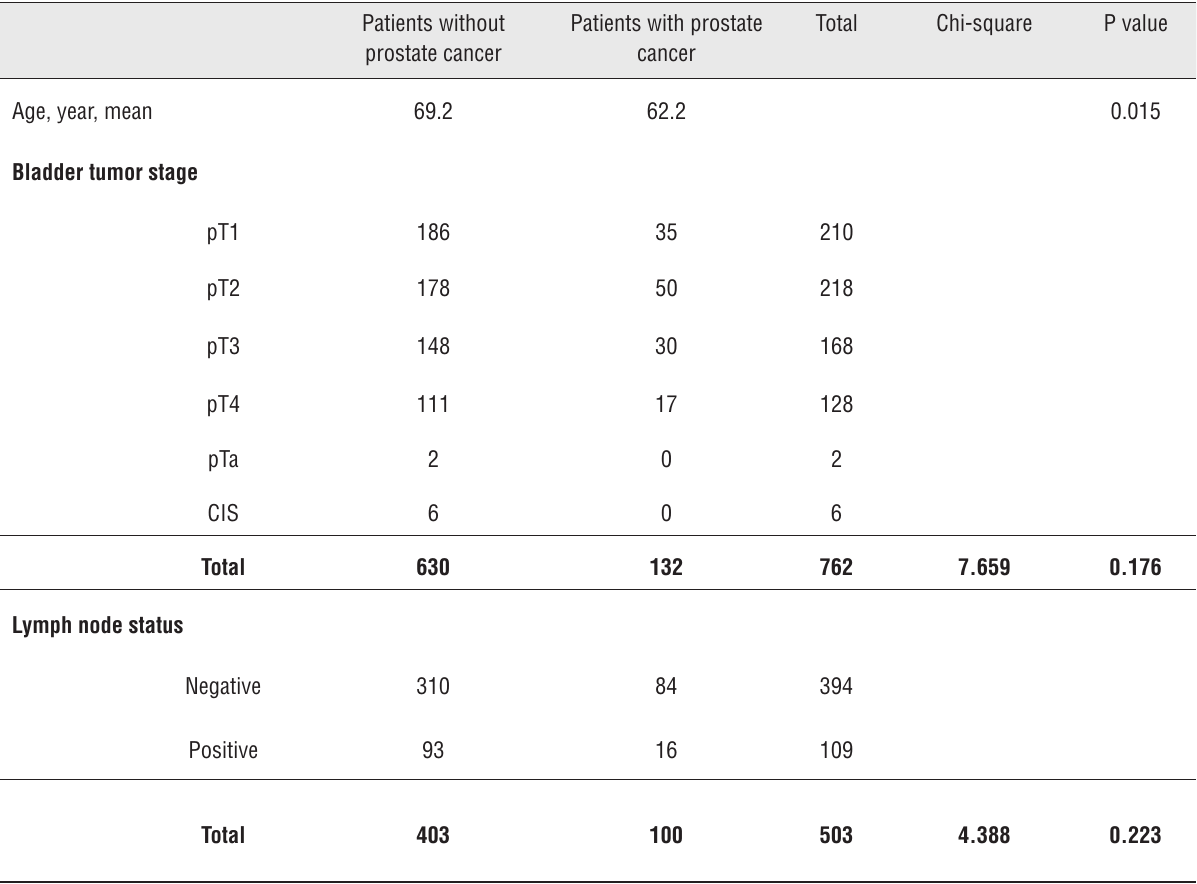
Table 1 - Comparison of clinical and pathologic characteristics between patients with or without incidental prostate cancer.